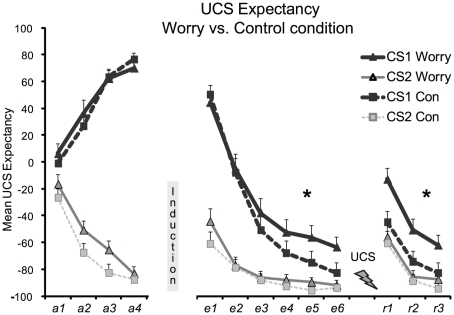
Worry manipulation after acquisition impairs extinction and re-extinction at the cognitive level of conditioned responding.Mean UCS expectancy ratings for the feared stimulus (CS1) and safe stimulus (CS2) during acquisition, extinction, reinstatement test and re-extinction for the Worry and Control condition (Con). Induction: worry or control manipulation; UCS with Flash: electric stimulus administered during reinstatement; Error bars reflect SEM.